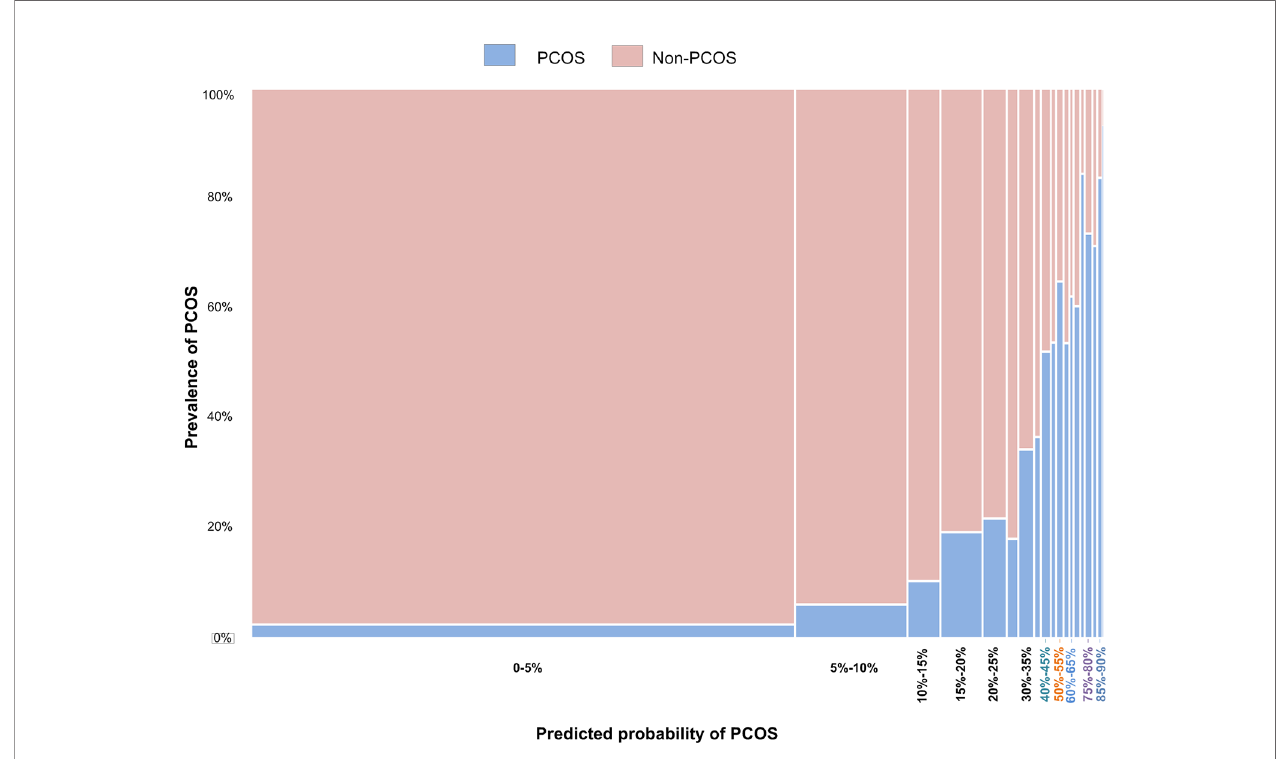
FIGURE 2 | The relationship between the prevalence of PCOS in women being treated by ART and the predicted probabilities using Model 3.